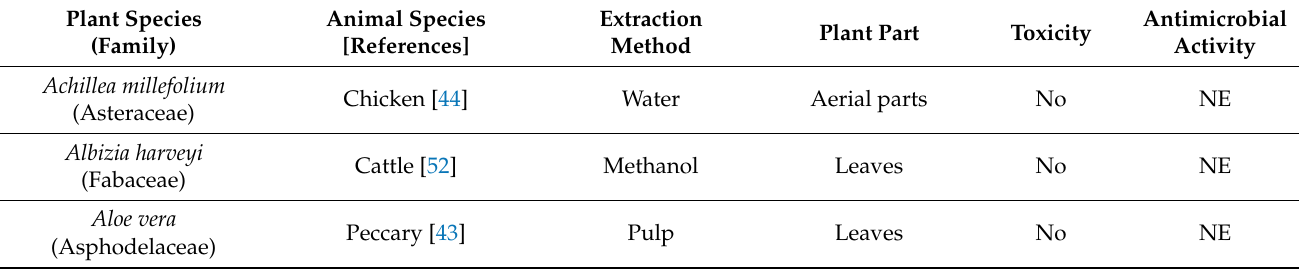
Table 1. Extraction methods, part of the plant used, toxicity, and antimicrobial activity of the plant species ( N = 45) tested in the different animal